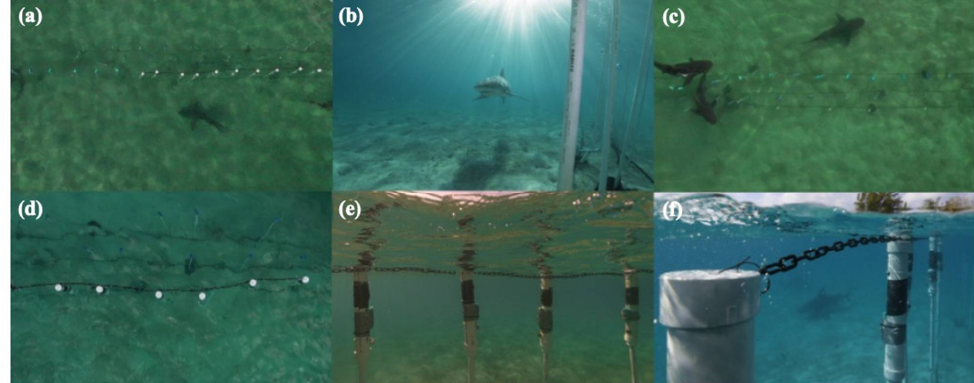
Figure 7. Photographs of the comparative barrier experiment. ( a ) An aerial view where a bull shark ( Carcharhinus leucas ) approaches the Exclusion barrier (i.e., white pipes) and another swims through the Sharksafe barrier (i.e., pipes with green/blue floats on surface). ( b ) A bull shark passes by the Sharksafe barrier. ( c ) Multiple bull sharks approach the Sharksafe barrier, with one entering through at the surface. ( d ) An aerial view of a section of the Exclusion barrier, with the first row being characterized by the large white pipes, whereas the subsequent rows (i.e., Row 2 and 3) are characterized by the smaller pipes. ( e ) A side profile of four pipes associated with the Exclusion barrier. ( f ) A bull shark passing by the Exclusion barrier.